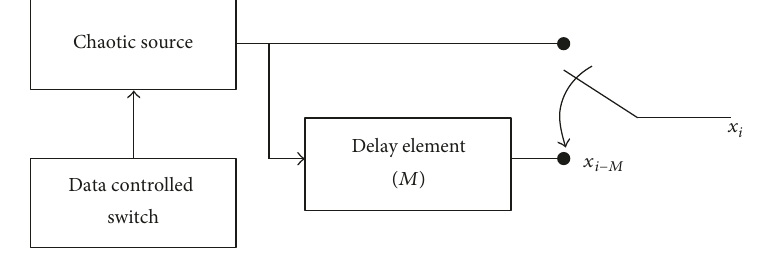
Figure 7: DCOOK transmitter.